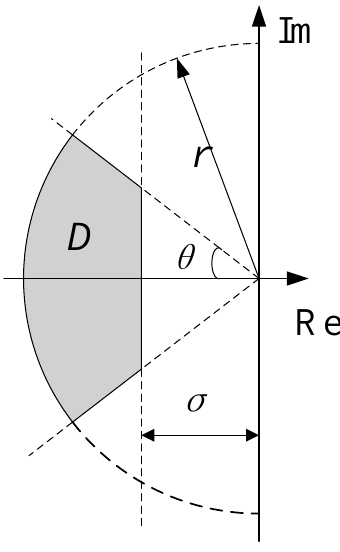
Figure 4. Region D in complex plane.